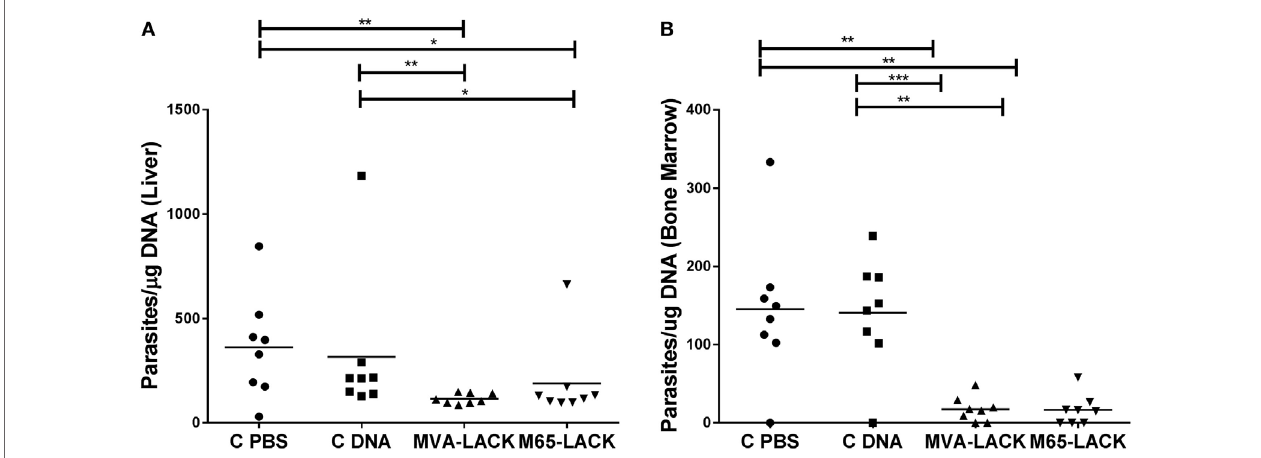
FigUre 5 | Liver and bone marrow amount of Leishmania DNA in the liver (a) and bone marrow (B) as determined by qPCR. * p ≤ 0.05, ** p ≤ 0.01, *** p ≤